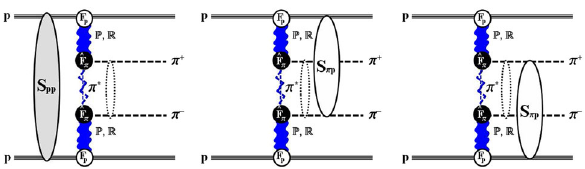
Fig. 2 Amplitude of the process of double pion LM CEDP p + p → p + π + + π − + p intheapproach[10–13].Thecentralpartofthediagram is the Born amplitude (with Pomeron and two reggeons). A mixture of reggeized and bare off-shell pion propagators is shown as a dashed zigzag line plus a dashed straight line. Proton–proton rescattering is depicted as the S pp -blob, and pion–proton rescattering corrections are also shown as S π p -blobs. The off-shell pion form factor is presented as a black